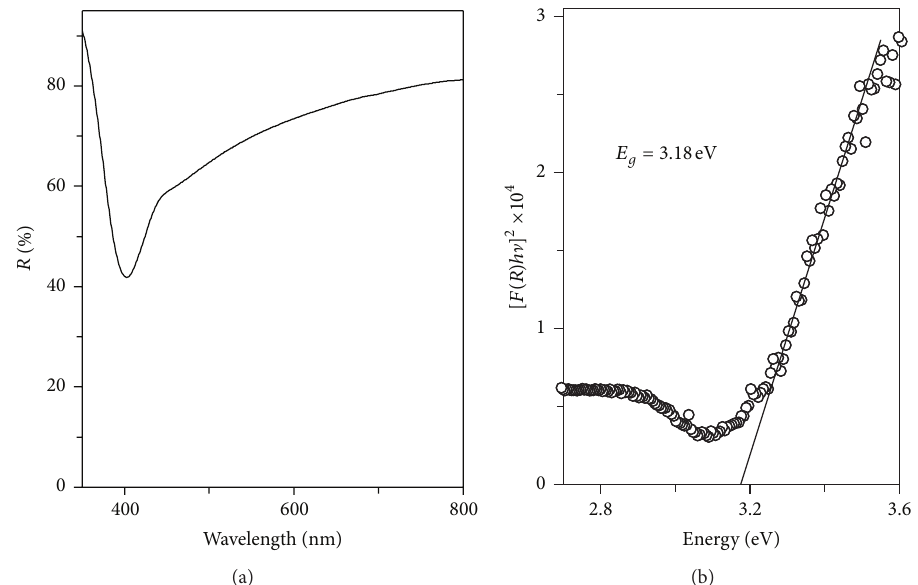
Figure 2: (a) Uv-Vis diffuse reflectance spectra of TiO 2 obtained at 450 ∘ C. (b) Band gap of the TiO 2 computed by Kubelka-Munk function, where 𝐸 𝑔 is the band gap energy, 𝑅 is the reflectance of the TD, ℎ is Planck’s constants, and ] is the frequency of the radiation.